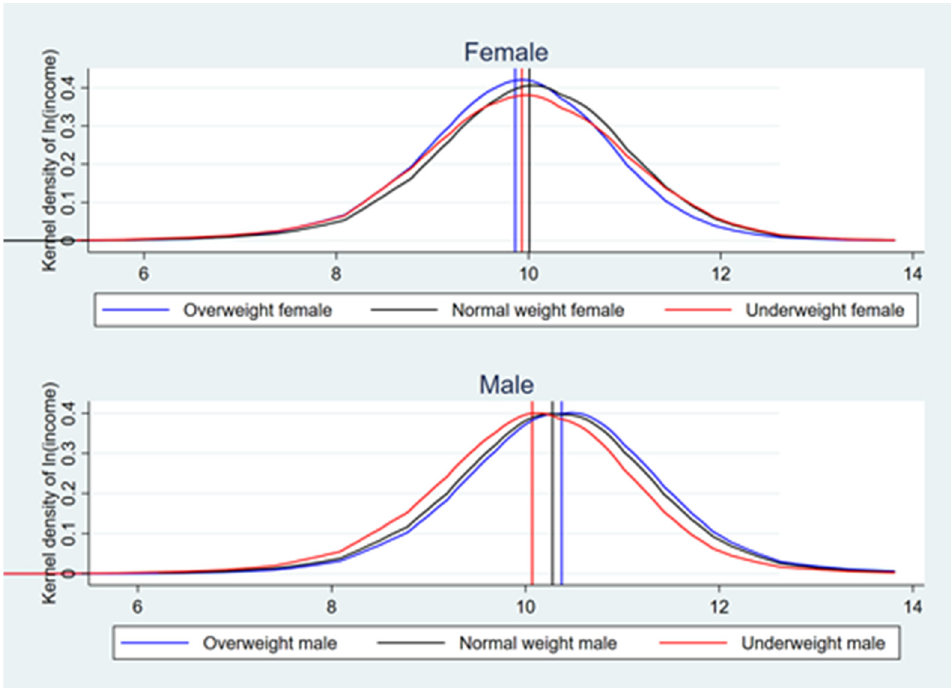
Figure 1 Kernel density of ln (income). Figure 1. Kernel density of ln